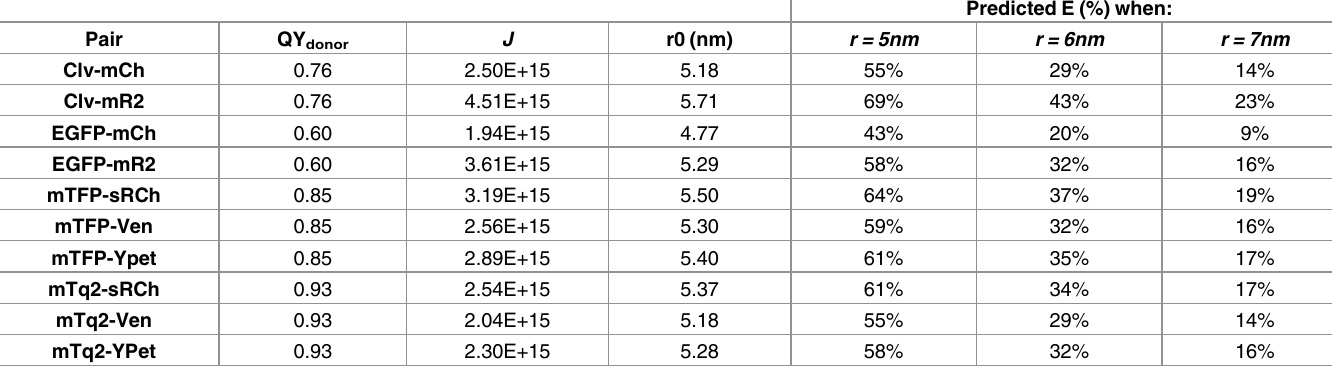
Table 2. Predicted FRET efficiencies fluorescent protein pairs. The Overlap Integral (J) of the spectra for each pair was calculated using the freeware program a|e— UV-Vis-IR Spectral Software (http://www.fluortools.com/software/ae), which uses the normalised emission spectrum of the donor and the normalised excitation spec- trum of the acceptor corrected for the published Extinction Coefficient (as detailed in Table 1) to determine the value of J in nm 4 /M.cm. The sources of each spectral data- set are detailed in the Supporting Information. The Forster Radius (r 0 ) for the pair was then calculated according to the equation detailed in the Materials and Methods section. Once r 0 was established an expected FRET Efficiciency at a given separation distance (r) was easily calculated according to the relationship E = r 0 6 /(r 0 6 +r 6 ). Predicted E (%)